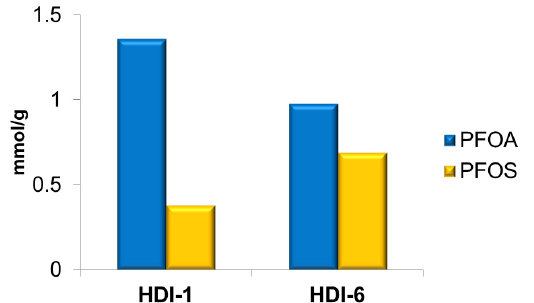
Figure 9. Adsorption of PFOA and PFOS on bulk CD-MIPs prepared using a cross-linker such as hexamethylene